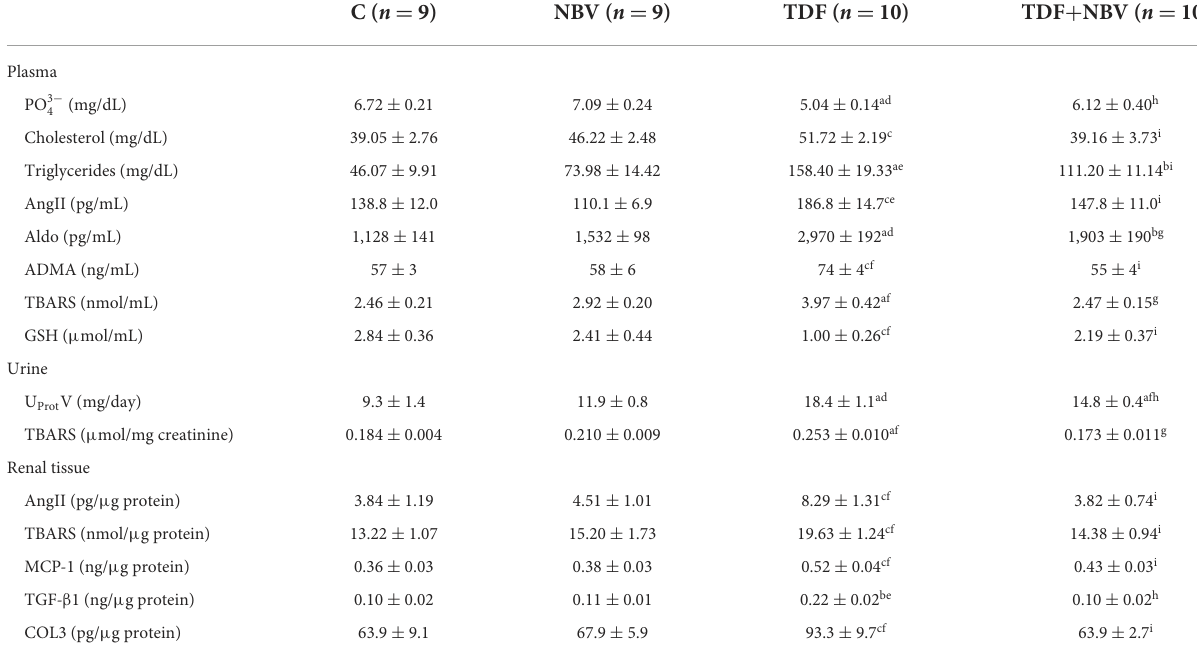
TABLE 2 Biochemical measurements and inflammatory/fibrosis markers evaluated after the 30-day protocol.